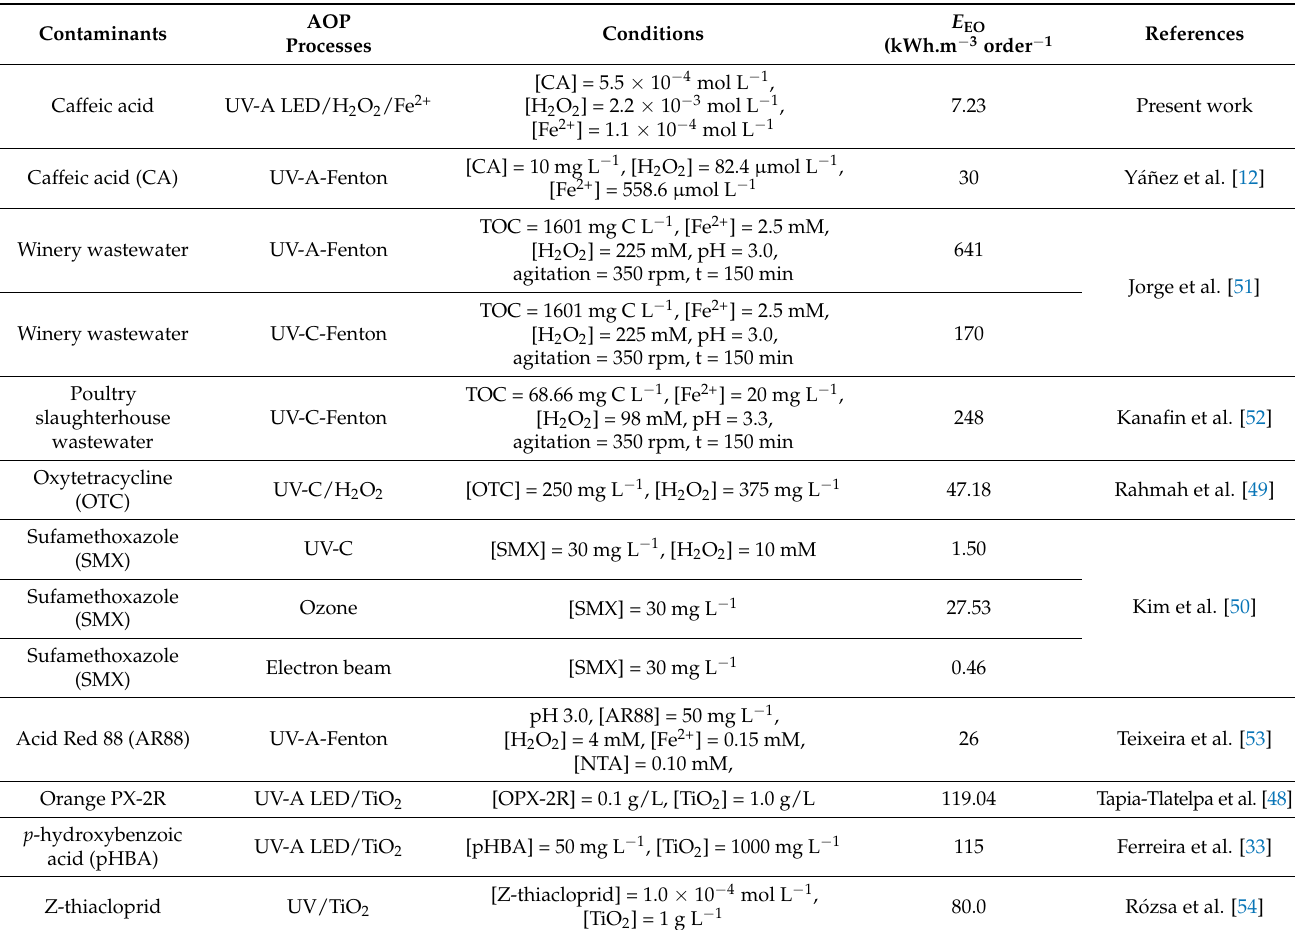
Table 2. Disclosed results of electric energy per order ( E EO ) obtained after degradation of single compounds by different treatment